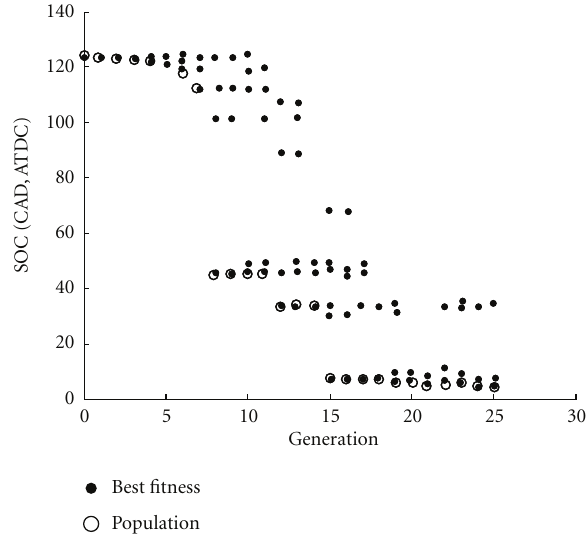
Figure 15: Optimization process (SOC timing versus Generation, calculated by changing the inlet temperature and equivalence